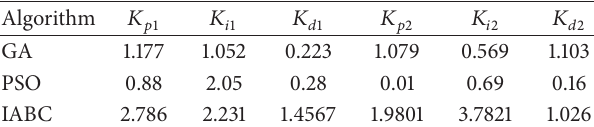
Table 2: PID controller gains of Case 1.